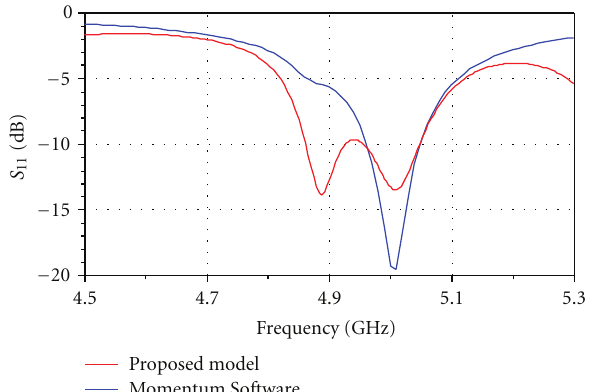
Figure 10: Simulated input antenna array return loss.